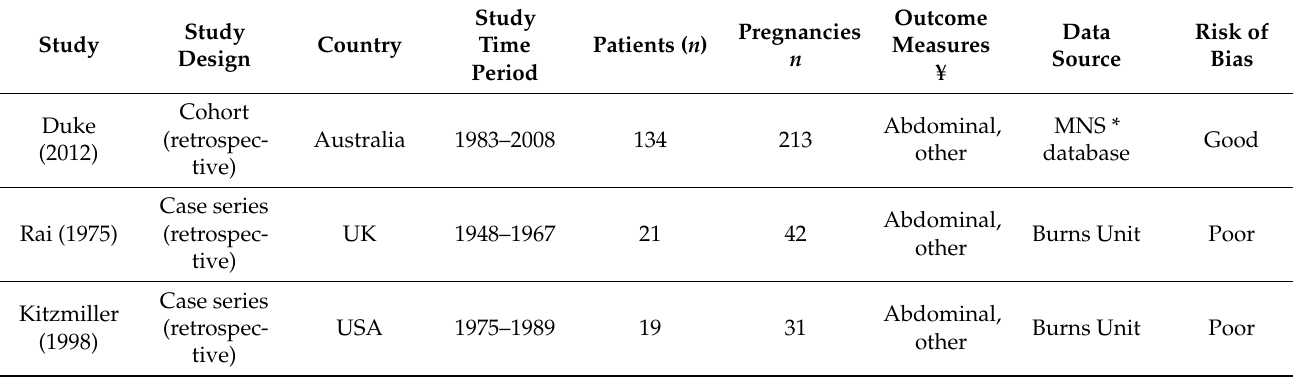
Table 1. Characteristics of included studies ( n = 22) by